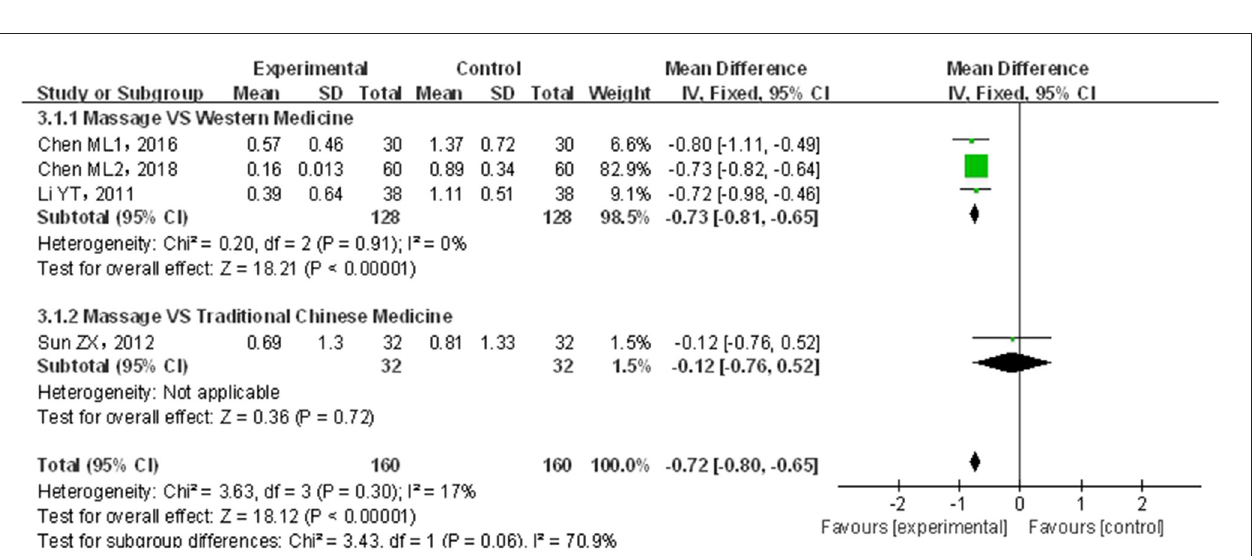
FIGURE 6 | Meta-analysis of infant massage and drug therapy in the treatment of children with functional constipation on change in defecation frequency.